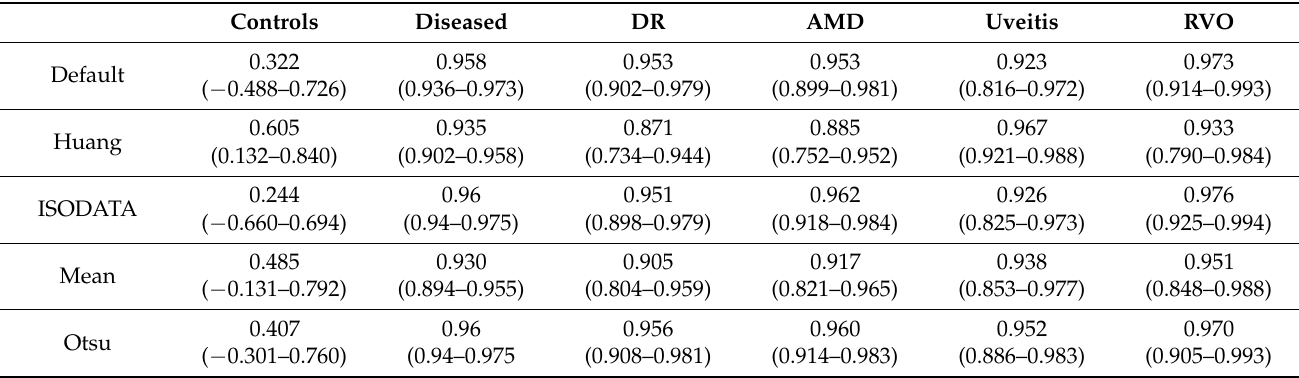
Table 3. Reliability analysis of the choriocapillaris slabs. The intraclass correlation coefficient and the respective 95% confidence interval are reported.